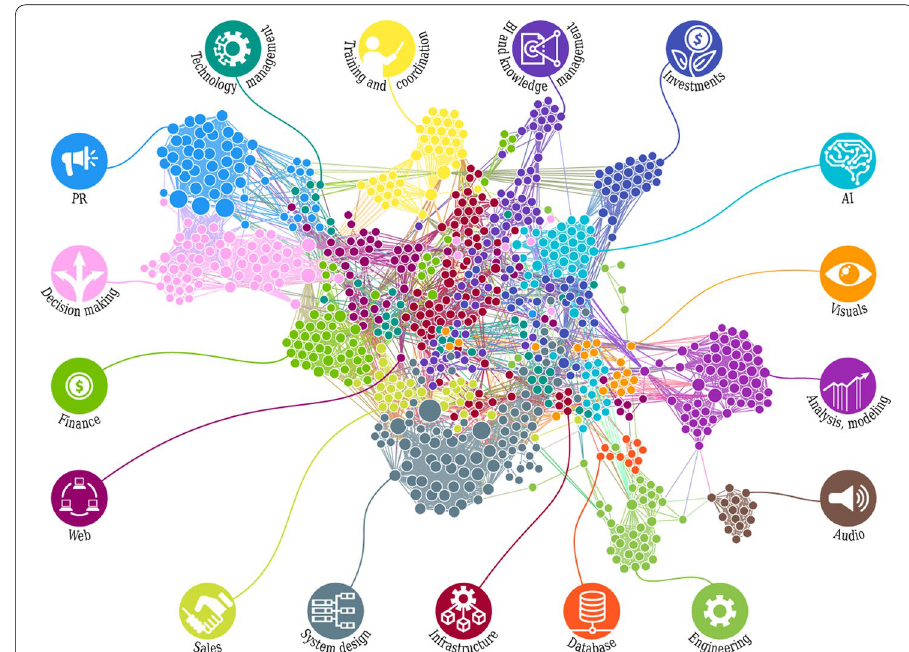
Fig. 3 Map of the skills’ relatedness. Nodes represent skills, and edges represent relatedness values with a threshold of t ij > 2. Colours represent communities detected by the Louvain algorithm. Similar skills tend to cluster